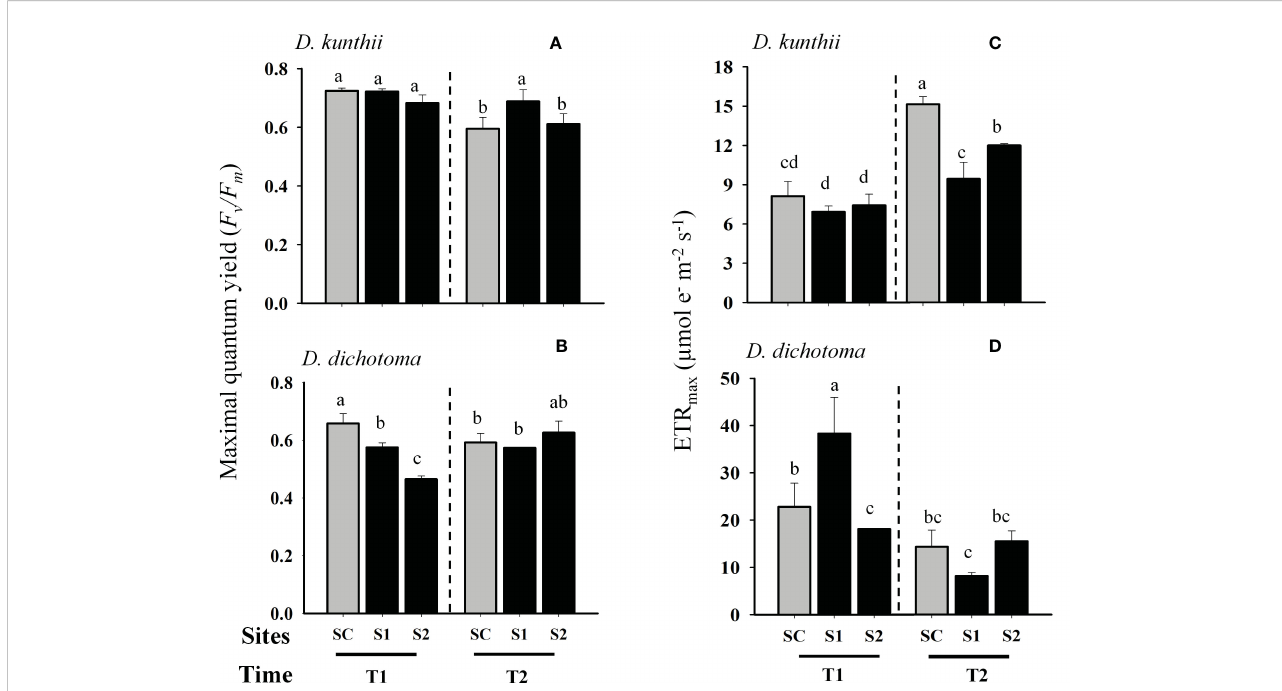
FIGURE 2 Photosynthetic responses as Maximum quantum yield ( F v /F m ) and Maximal electron transport rate (ETR max ) in D. kunthii and D. dichotoma transplant under the in fl uence of brine discharge from a desalination plant. In D. kunthii , F v /F m (A) and ETR max (C) were measured at 2 impacted sites with low (S1) and high (S2) in fl uence from brine discharge from a desalination a plant located in Antofagasta, Chile and using a control site (SC) 3 (T1) and 7 (T2) days. In D. dichotoma , F v /F m (B) and ETR max (D) were measured at 2 impacted with low (S1) and high (S2) in fl uence from brine discharge from a desalination plant located in Alicante, Spain, using a control site (SC) at 3 (T1) and 6 (T2) days. Data corresponds to mean ± SD ( n = 3). Letters represent statistical difference at 95% con fi dence interval (SNK test, p <